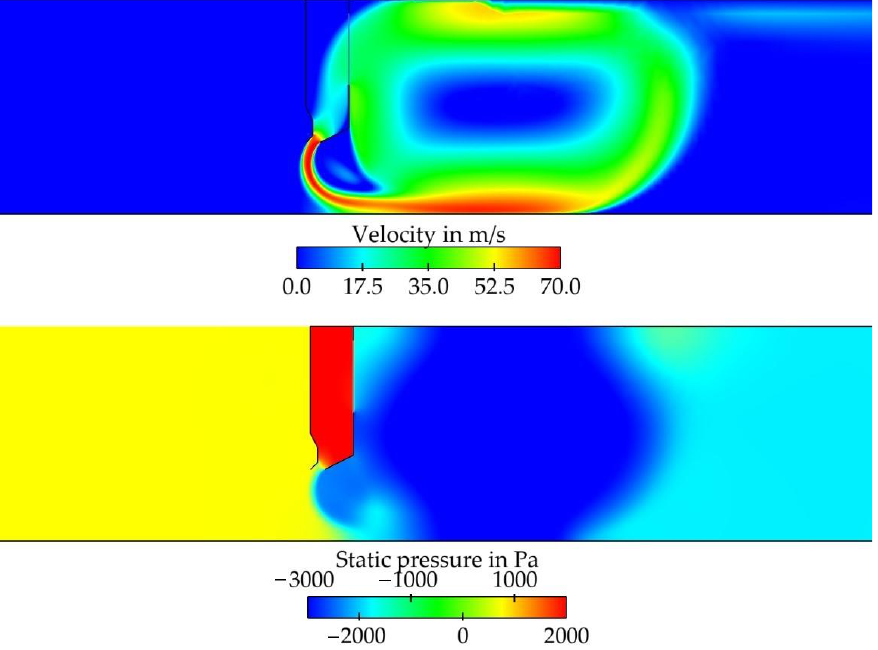
Energies 2022 , 15 , x FOR PEER REVIEW 10 of 29